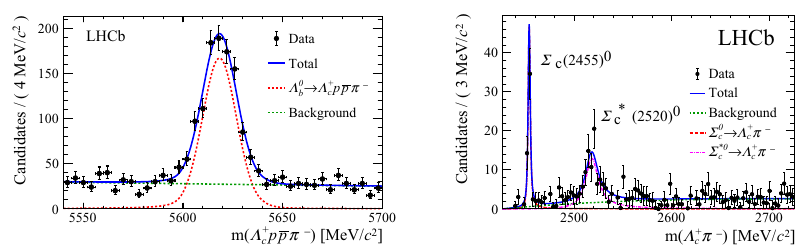
π − system from c